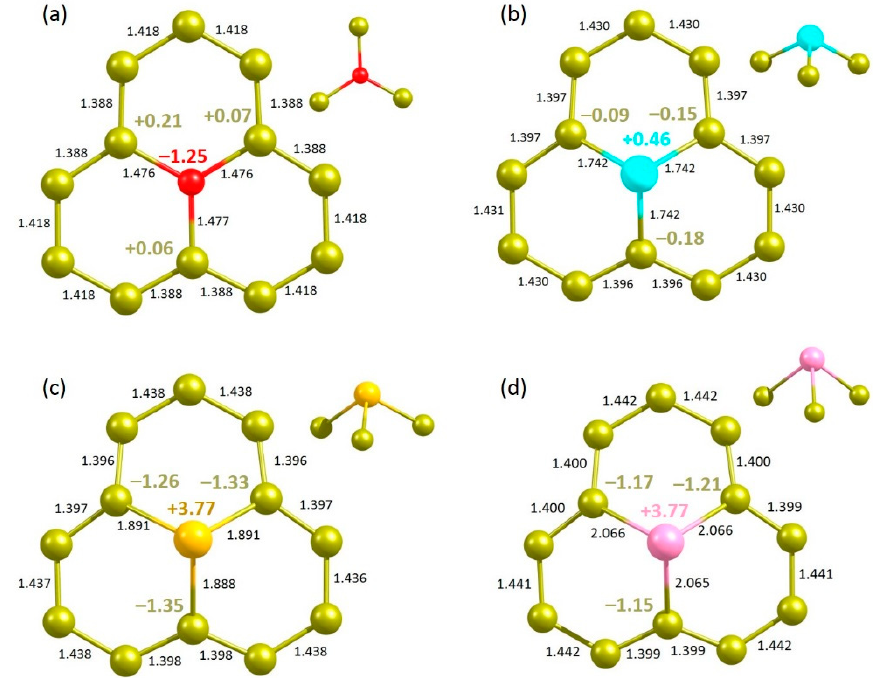
Figure 7. Relaxed structures of ( a ) O-, ( b ) S-, ( c ) Se- and ( d ) Te-doped graphene. DOS plots show that p states of S, Se and Te mainly occupy the band gap region (see Figure 8). Charge density plots show the electron distribution around the doped atoms and the nearest neighbour C atoms as observed in the Bader charge analysis. Table 5 . Calculated substitution energies, Bader charges on the doped atoms, and bond distances (C-X) . X in X@Graphene (X